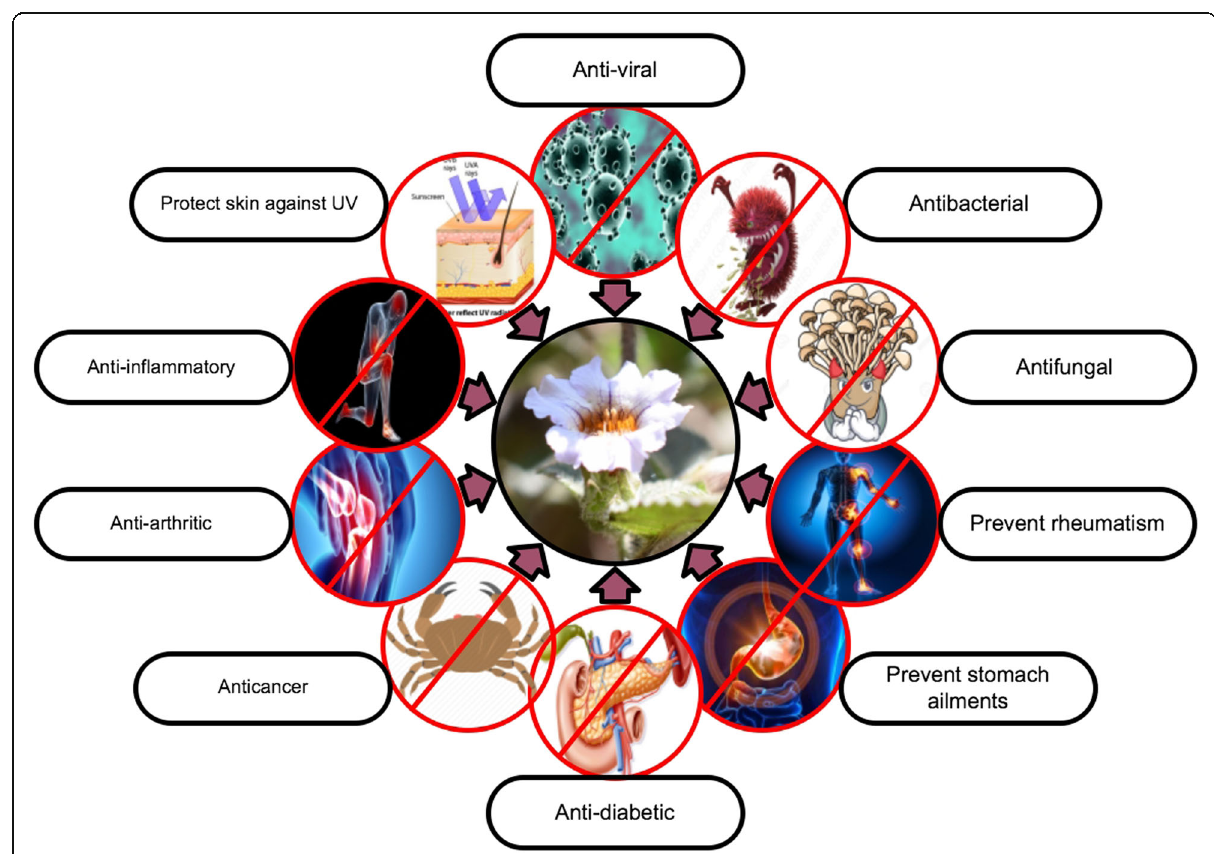
Fig. 3 Diagrammatic presentation of selected pharmacological properties of Neelakurinji ( Strobilanthes Kunthianus Nees T Anders) ( Source : unpublished photograph of Soumen